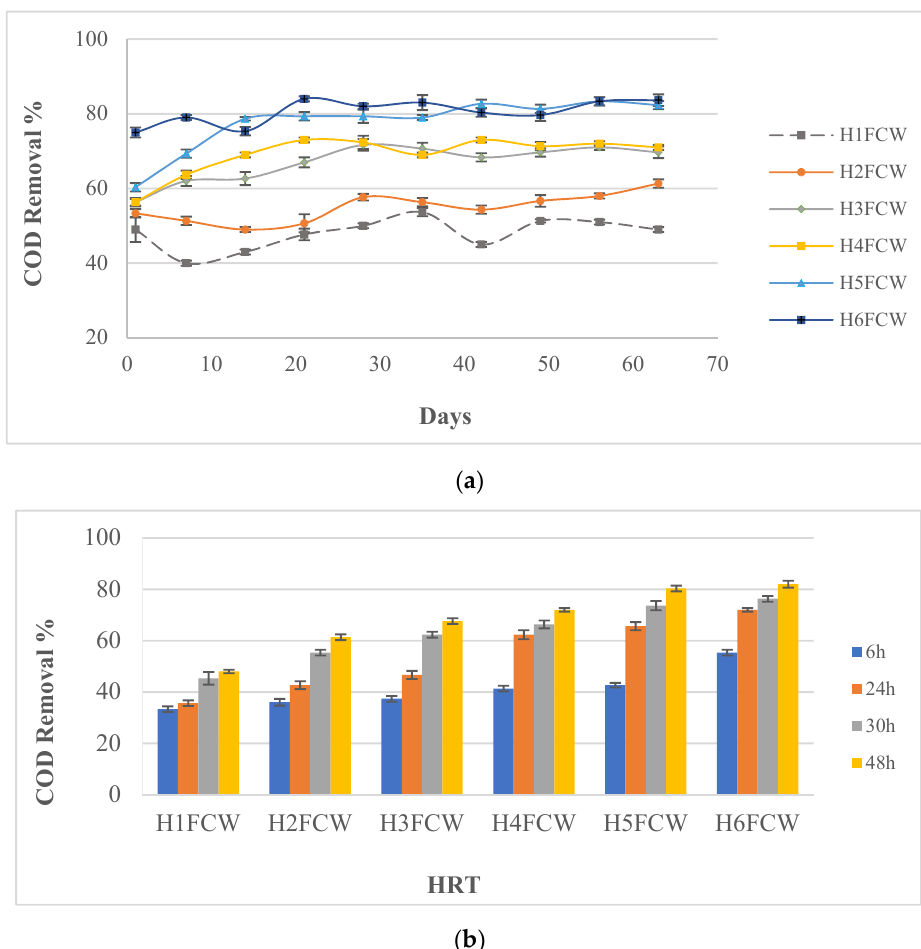
Figure 3. ( a ) COD efficiency removal in different mesocosm horizontal flow constructed wetlands (HFCWs) after 48 h. ( b ) Hydraulic retention time effect on the COD removal.